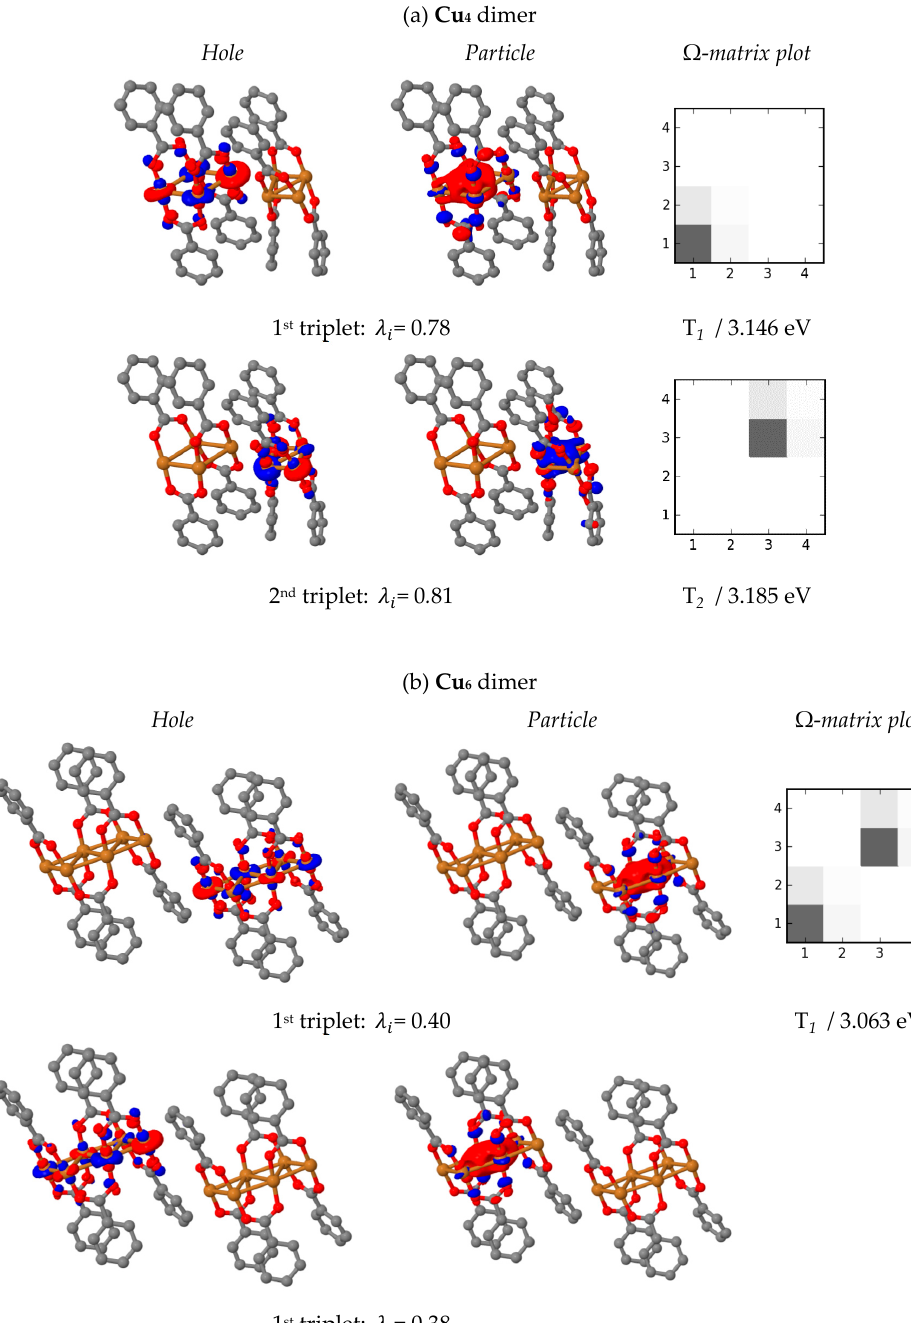
Figure 10. Dominant NTO pairs and electron-hole correlation plots for T 1 and T 2 states of the Cu 4 dimer ( a ) and T 1 state of the Cu 6 dimer ( b ) (isosurfaces drawn at ± 0.04 a.u.; blue—positive; red—negative) obtained at the CAM-B3LYP/cc-pVDZ level of theory. Fragments 1 and 3 correspond to Cu n cores, whereas fragments 2 and 4 include all PhCO 2 ligands attached to the 1st and 3rd core,